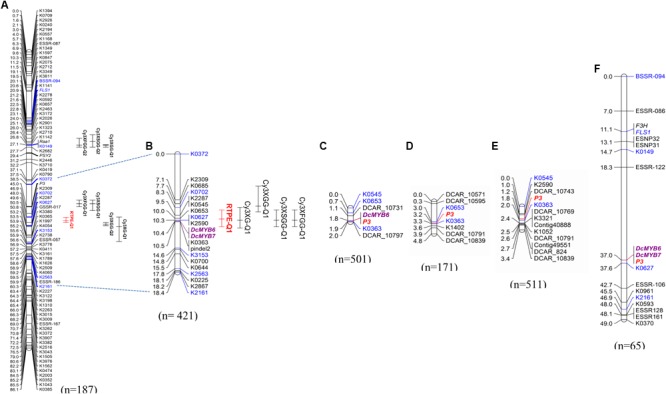
Genetic mapping of anthocyanin pigment traits in chromosome 3 of different carrot populations. QTL for ‘root total pigment estimate’ (RTPE) and root anthocyanin pigments (Cy3XG, Cy3XGG, Cy3XSGG, and Cy3XFGG) mapped in the original framework linkage map published by Cavagnaro et al. (2014)
(A). High-resolution mapping in the RTPE-Q1 region using a larger 70349 population (B). The connecting dotted lines indicate the flanking markers of the map region further analyzed in this work. In (A,B), bars to the right of the linkage groups represent support intervals of the QTL. RTPE-Q1, explaining 52.3% of the variation, is denoted in red. The P3 locus, conditioning root and leaf pigmentation, was mapped in populations 95710 (C), 5394 (D), 5723 (E), and 2170 (F). Population size is indicated in parenthesis under each linkage group. Markers in blue denote common markers across different maps. Two anthocyanin candidate MYB genes, DcMYB6 and DcMYB7, are denoted in bold purple letters.